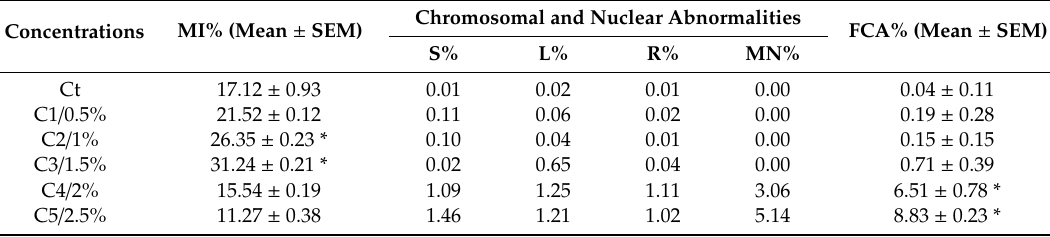
Table 1. Microscopic e ff ects of AESF at di ff erent concentrations on meristematic cells of A. cepa.